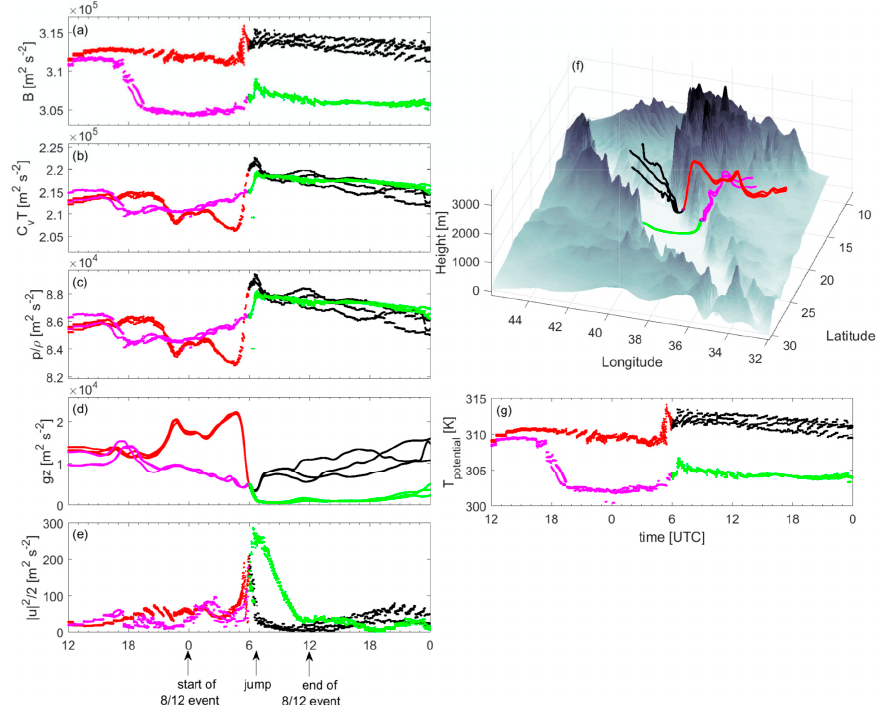
Figure 16. The Bernoulli function ( a ) and its constituents ( b – e ) as functions of time (UTC) following the six trajectories plotted ( f ). The three pink / green trajectories pass through the Tokar Gap while the three red / black trajectories pass through Gap 2. The trajectories are initiated at the (blue) transition point and integrated back and forward in time. Frame ( g ) shows potential temperature along the four trajectories. The unevenness of some of the curves is a result of the interpolation